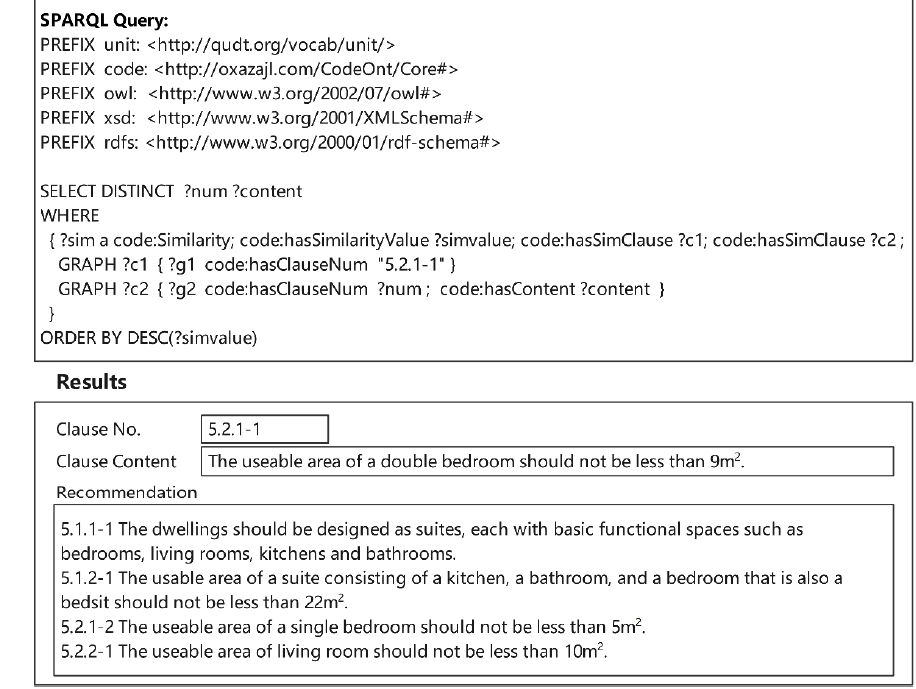
Figure 20. SPARQL query to retrieve the recommended clauses for clause 5.2.1-1.